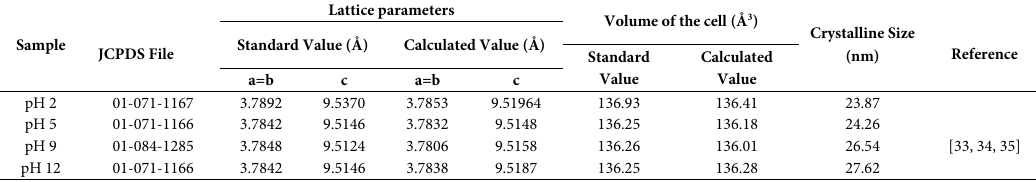
at pH 2,5,9,12 on annealed at 475ºC. 2